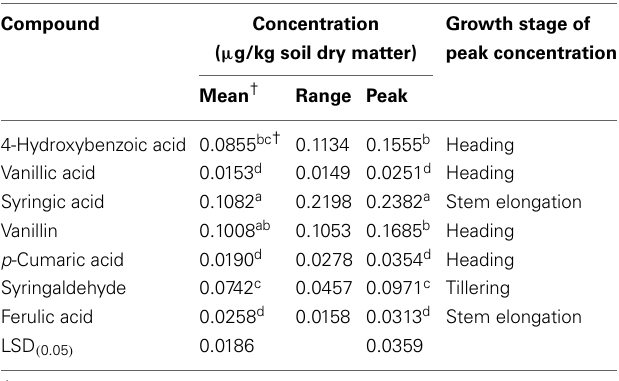
Table 1 | Mean concentrations and ranges of the seven phenolic compounds identified in the rhizosphere soil of wild